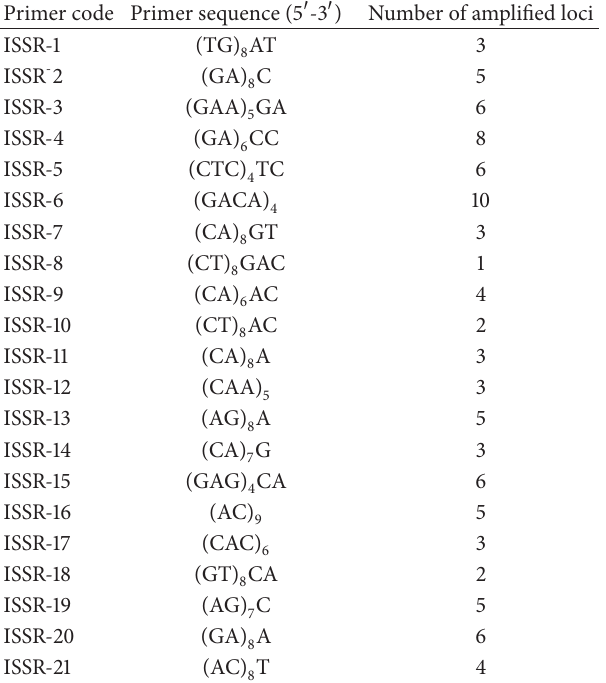
Table 2: Reproducible ISSR primers, their sequences, and total number of amplified